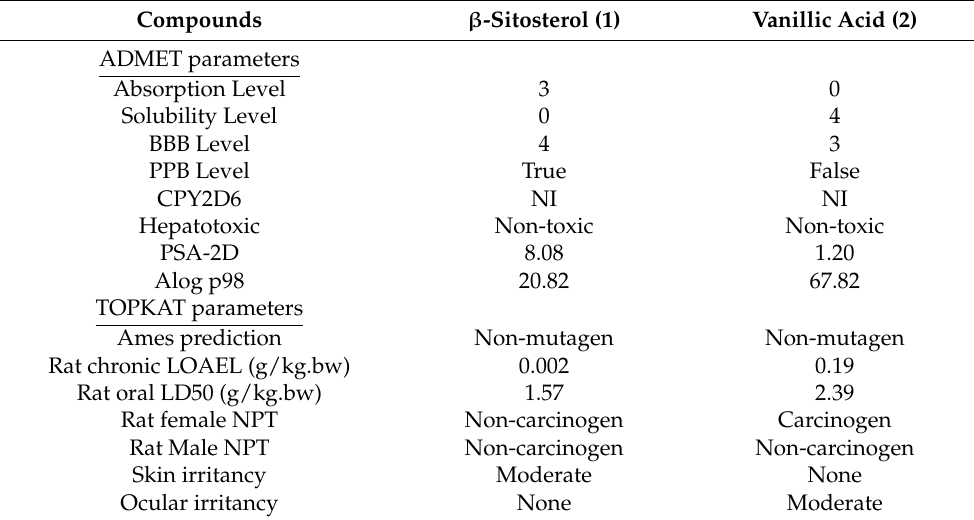
Figure 5. ADMET Plot for β-sitosterol ( 1 ) (circle) and vanillic acid ( 2 ) (star) isolated from D. bupleu- roides displaying 95% and 99% confidence limit ellipses corresponding to the blood-brain barrier (BBB) and the human intestinal absorption models in ADMET_AlogP98. Table 4. ADME/TOPKAT (absorption, distribution, metabolism, excretion, and toxicity) evaluation of β -sitosterol ( 1 ) and vanillic acid ( 2 ) isolated from D. bupleuroides